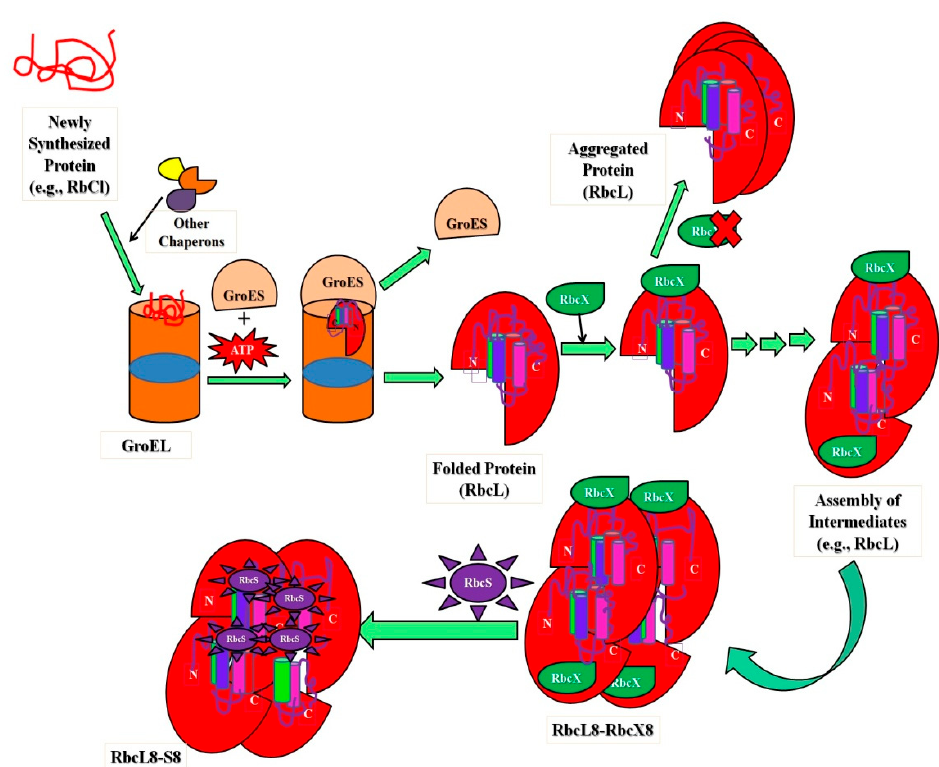
Figure 2. Schematic representation showing the importance of intermediates in folding and assembly of L8S8 Rubisco (cyanobacterial) mediated by GroEL/GroES and